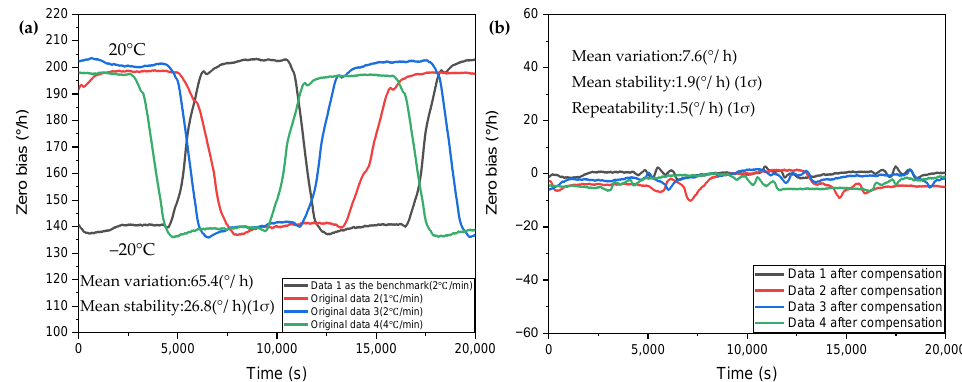
Figure 8. Determine the regression equation with data 1, and use the regression equation to compen- sate for the compensation results of other data. ( a ) Before compensation. ( b ) After compensation. Table 3. Determine the regression equation with data 1, and use the regression equation to compen- sate for the effect comparison of other data.